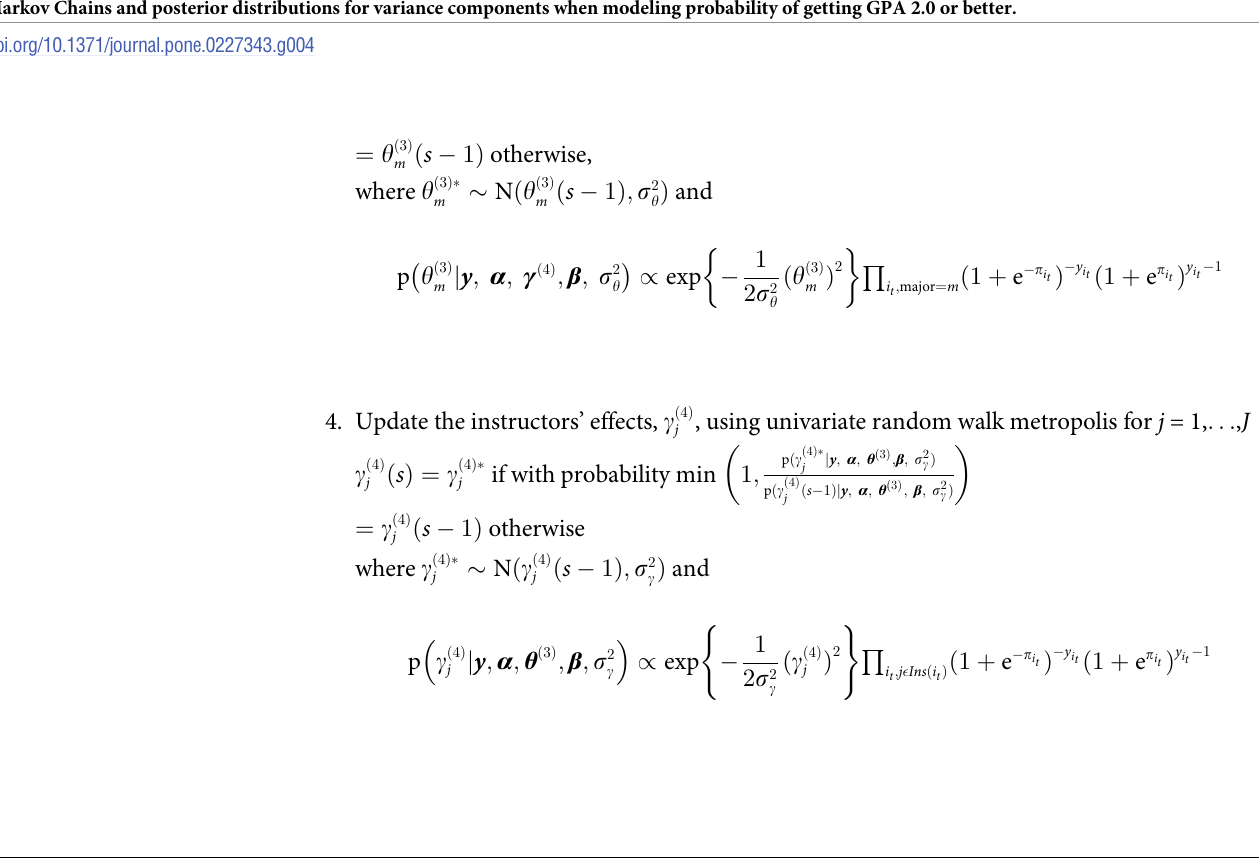
PLOS ONE | https://doi.org/10.1371/journal.pone.0227343 January 30,